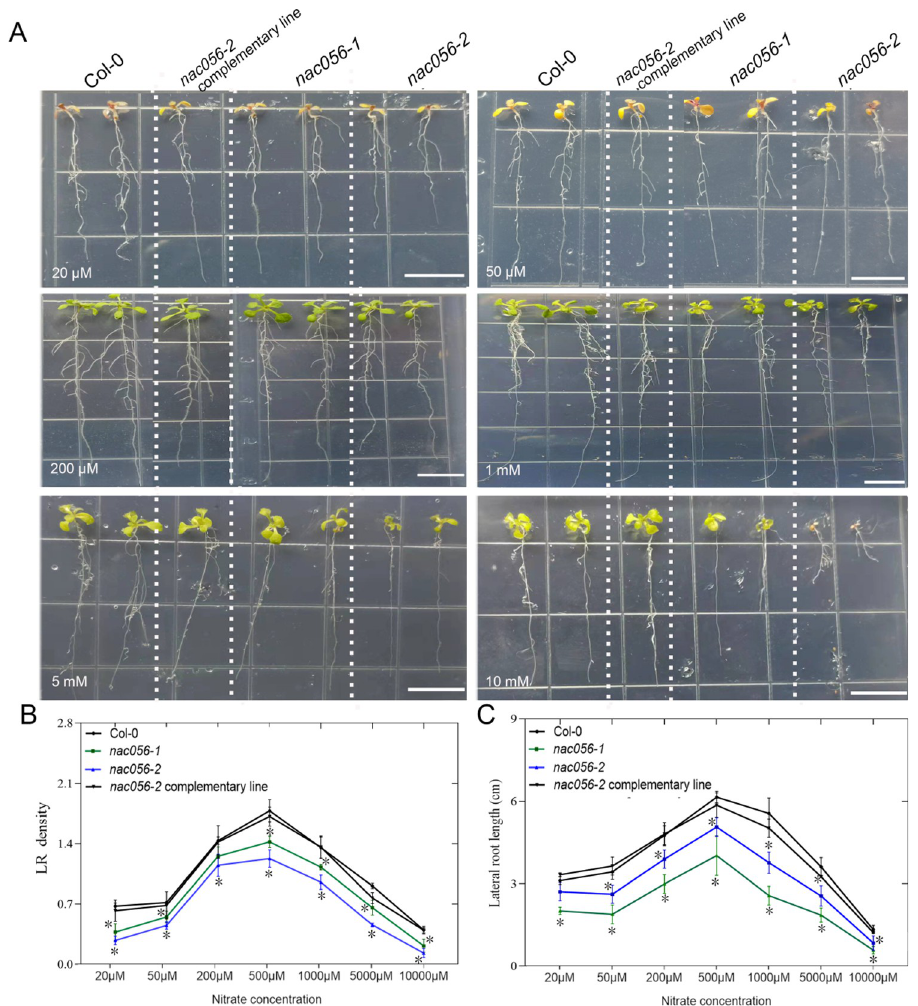
Fig 5. Nitrate-promoted root growth analysis in Col-0 and the nac056 mutants. A. Effects of various concentrations of nitrate (20 μ M, 50 μ M, 200 μ M, 500 μ M, 1 mM, 5 mM or 10 mM) on root growth. WT, nac056 mutants, and the complemented mutant line were grown vertically in medium supplemented with different nitrate concentrations for eight days. B. LR density; C. lateral root length were quantified. LR density was calculated as the LR number per 1 cm of primary root. � indicates significant difference from Col-0 ( p < 0.05) by Student’s t -test. Data are mean ± standard error (SE) (n = 4). The black bars indicate 1.2 cm.